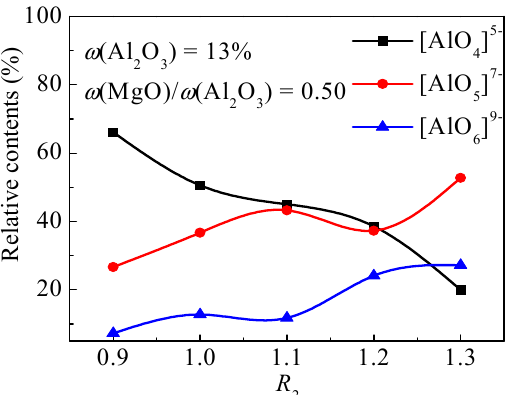
Figure 11. Relative content curves of [AlO 4 ] 5 − , [AlO 5 ] 7 − , and [AlO 6 ] 9 − with various R 2 . Figures 12 and 13 show the 27 Al-SS-MAS-NMR peak separation results of the slag under different ω (MgO)/ ω (Al 2 O 3 ) conditions and the relative content of the Al structural unit of each coordination with the ω (MgO)/ ω (Al 2 O 3 ) curve. As the ω (MgO)/ ω (Al 2 O 3 ) ratio increased from 0.35 to 0.60, the relative content of the [AlO 4 ] 5 − tetrahedral structural units of four-coordinated Al decreased gradually from 64.0% to 26.5%. The relative content of the [AlO 5 ] 7 − pentahedral units and [AlO 6 ] 9 − octahedral units increased from 29.6% to 44.8% and from 6.4% to 28.7%, respectively. As the ω (MgO)/ ω (Al 2 O 3 ) ratio increased, the structure of Al in the slag changed from [AlO 4 ] 5 − tetrahedral structure to [AlO 5 ] 7 − pentahedral structure and [AlO 6 ] 9 − octahedral structure (Figure 14). The content of [AlO 5 ] 7 − octahedral units was highest, but its relative content decreased when the ω (MgO)/ ω (Al 2 O 3 ) ratio was above 0.55. In regard to energy-saving ability in the production of BF, the ω (MgO)/ ω (Al 2 O 3 ) ratio should be controlled at less than 0.55.